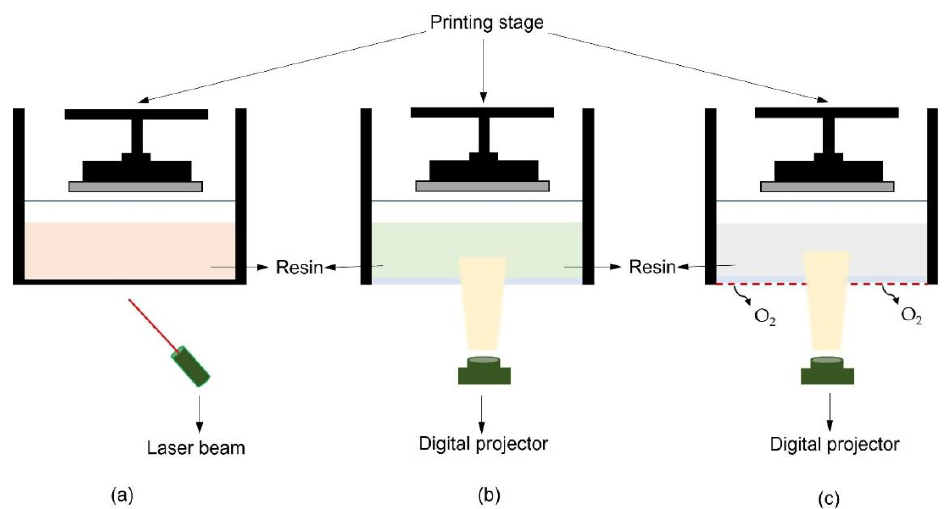
Figure 5. Schematic prototype of light source-triggered based printers: ( a ) simplified SLA printer; ( b ) simplified bottom-up DLP printer; and ( c ) simplified CLIP printer.